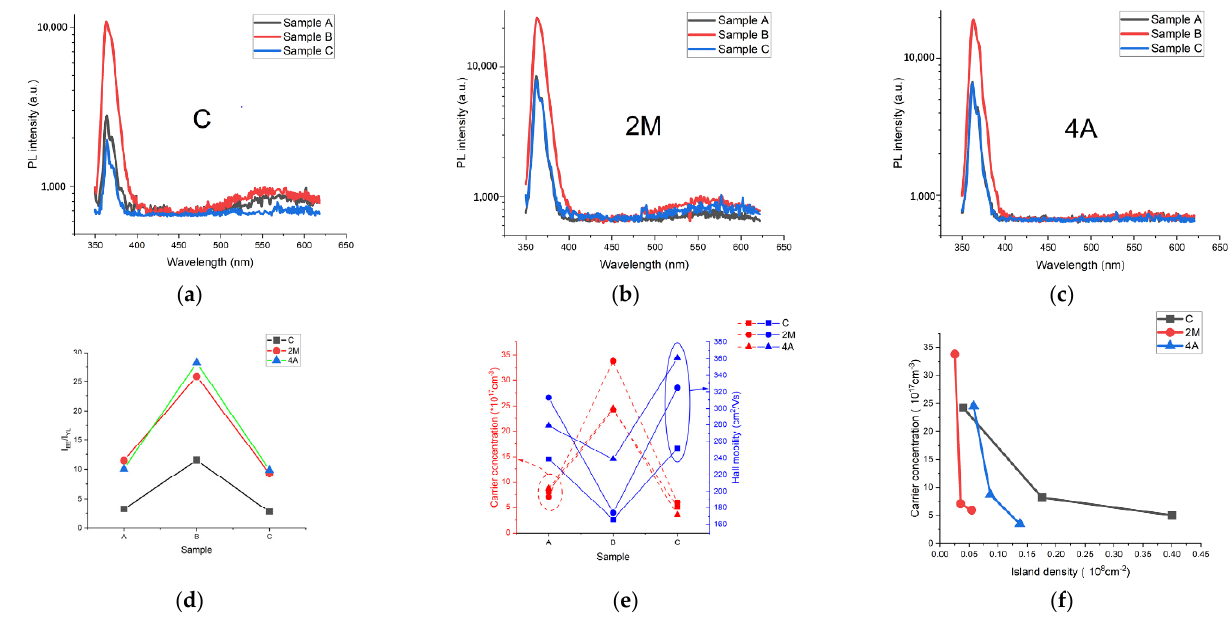
Figure 4. Room-temperature PL results of samples A, B, and C grown on C: ( a ); 2M: ( b ); 4A: ( c ); substrate. I BE /I YL results of all samples: ( d ). Summary of the Hall measurement results: ( e ) and the relation between carrier concentration and island density formed after KOH etching: ( f ).